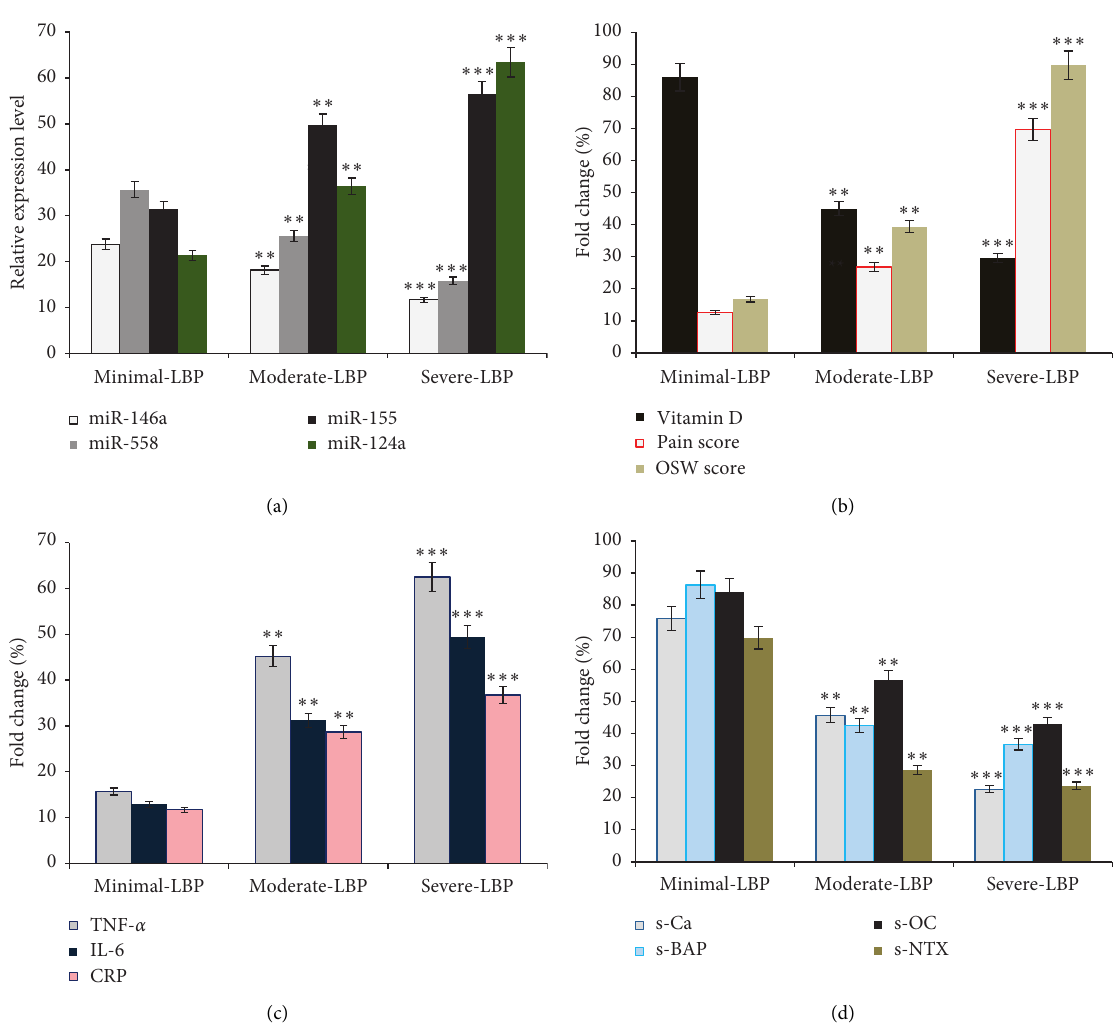
Figure 1: Changes in biological parameters in subjects with different LBP scores. Significant changes were reported in the expression of miRNAs; miR-146a and miR-558 were significantly downregulated and miR-155 and miR-124a were significantly upregulated in subjects with moderate to severe LBP scores compared to subjects with minimal LBP scores (a). A significant decrease in the levels of vitamin D and an increase in pain and LBP-OSW scores were reported in subjects with moderate to severe LBP, compared to those with minimal LBP scores (b). Inflammatory markers as TNF- α , IL-6, and CRP were significantly increased in subjects with moderate ( p � 0 . 01) and severe ( p � 0 . 001) LBP scores compared to normal controls (c). In addition, biosynthesis of bone metabolism markers as s-Ca, s-BAP, s-OC, and s- NTX was significantly reduced in subjects with moderate ( p � 0 . 01) and severe ( p � 0 . 001) LBP compared to subjects with minimal LBP scores